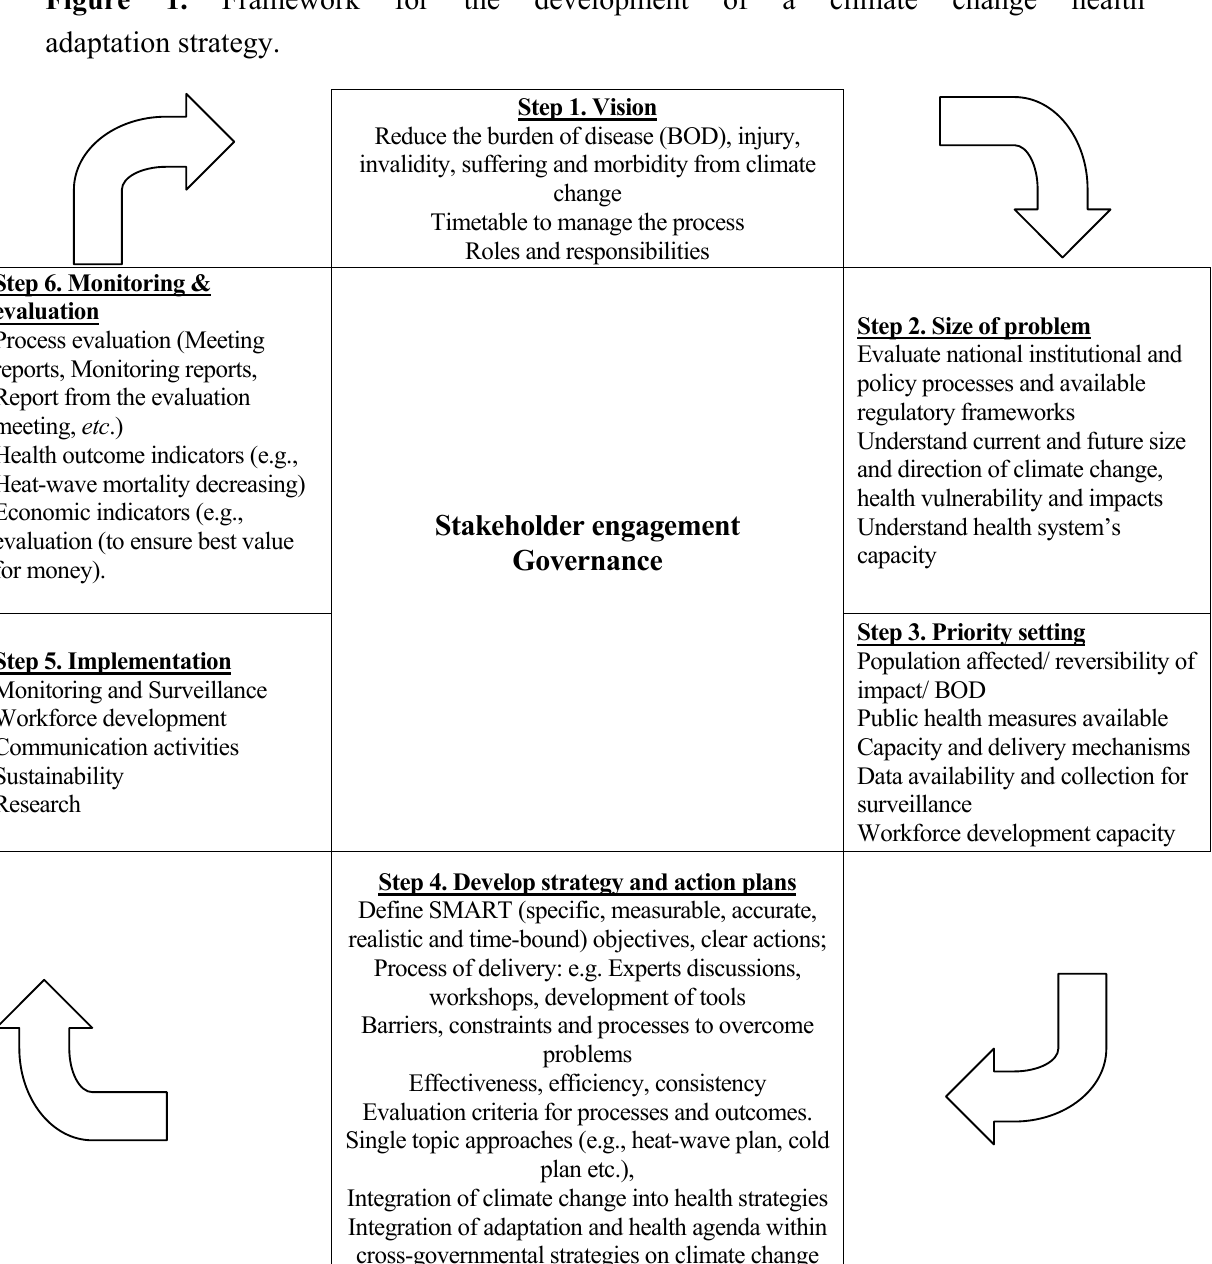
Figure 1. Framework for the development of a climate change health adaptation strategy. Step 1. Vision Reduce the burden of disease (BOD), injury, invalidity, suffering and morbidity from climate change Timetable to manage the process Roles and